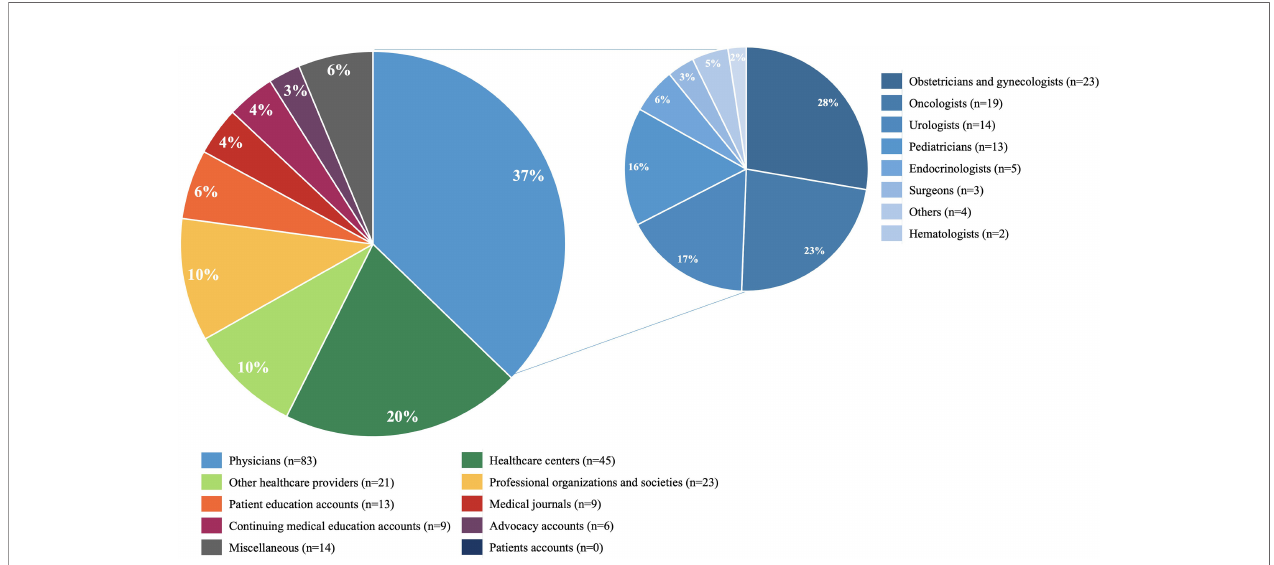
FIGURE 2 | Distribution Twitter accounts according to the type of user holder (larger pie) and medical specialty distribution if the user was a physician (smaller